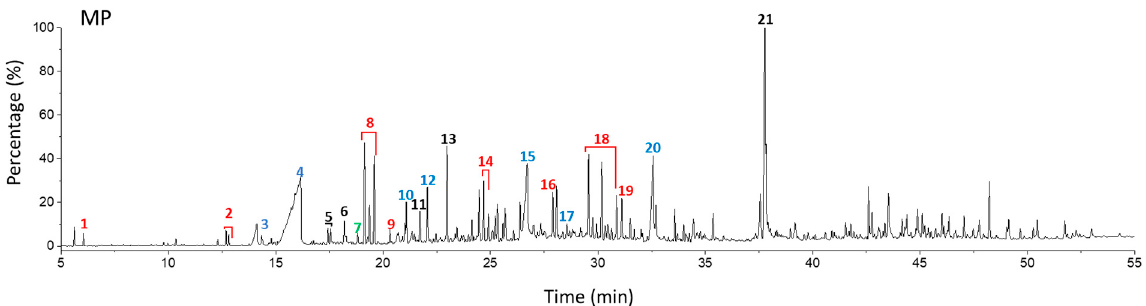
Figure 3. TED-GC-MS chromatogram of MP. The color of the number indicates the origin: red: PP, blue: PET, green: PVC, black: compounds newly appearing in MP. Table 1. Thermal-degradation compounds of MP shown in Figure 3.